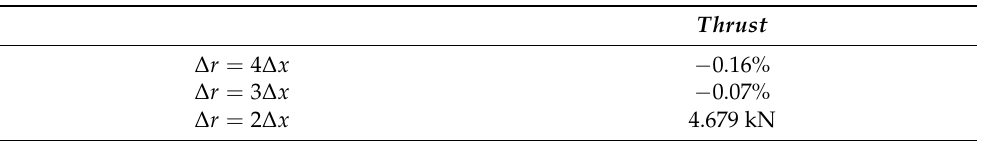
Figure 14. MR hexa grid setup. Table 7. Variation of thrust [kN] with increasing blade grid size ∆ r [m]. Reference thrust corresponds to minimum value ∆ r = 2 ∆ x .